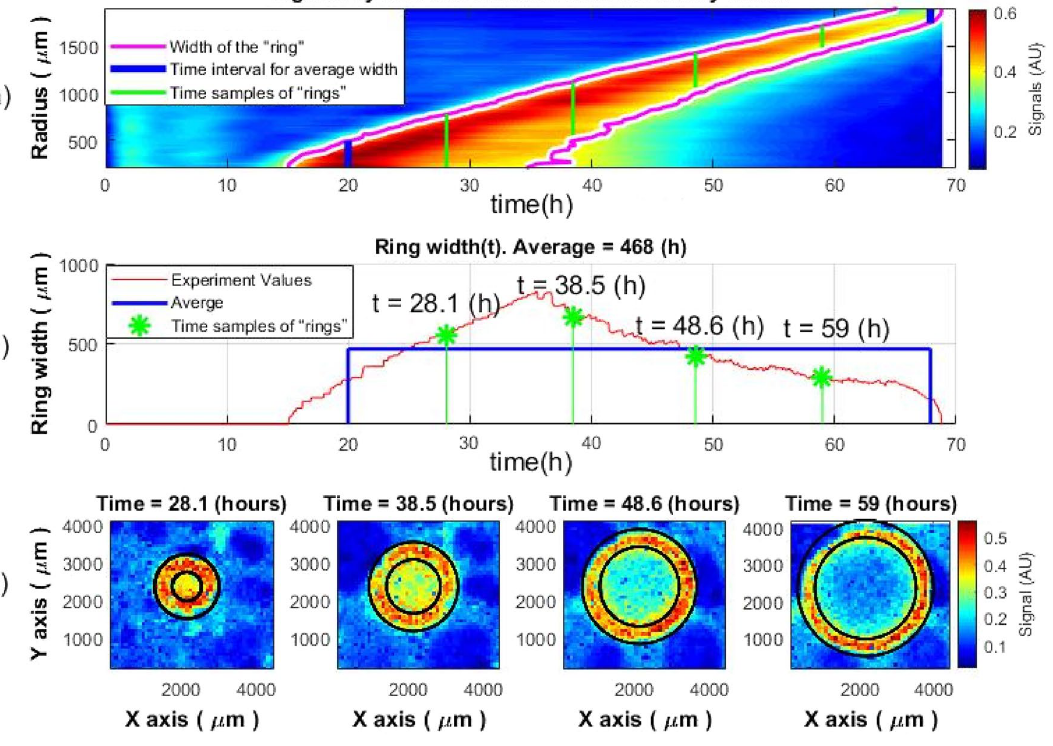
Figure 9. Determination of the width of the activity “ring” for the colony of S. aureus : ( a ) signal values and determined width of the activity ring (purple line), ( b ) the obtained width of the activity “ring”, ( c ) comparison of the obtained width of the activity “ring” (black lines) for one colony at different times. Similar spatiotemporal behavior of the signal was observed also within colonies of E. coli and V.